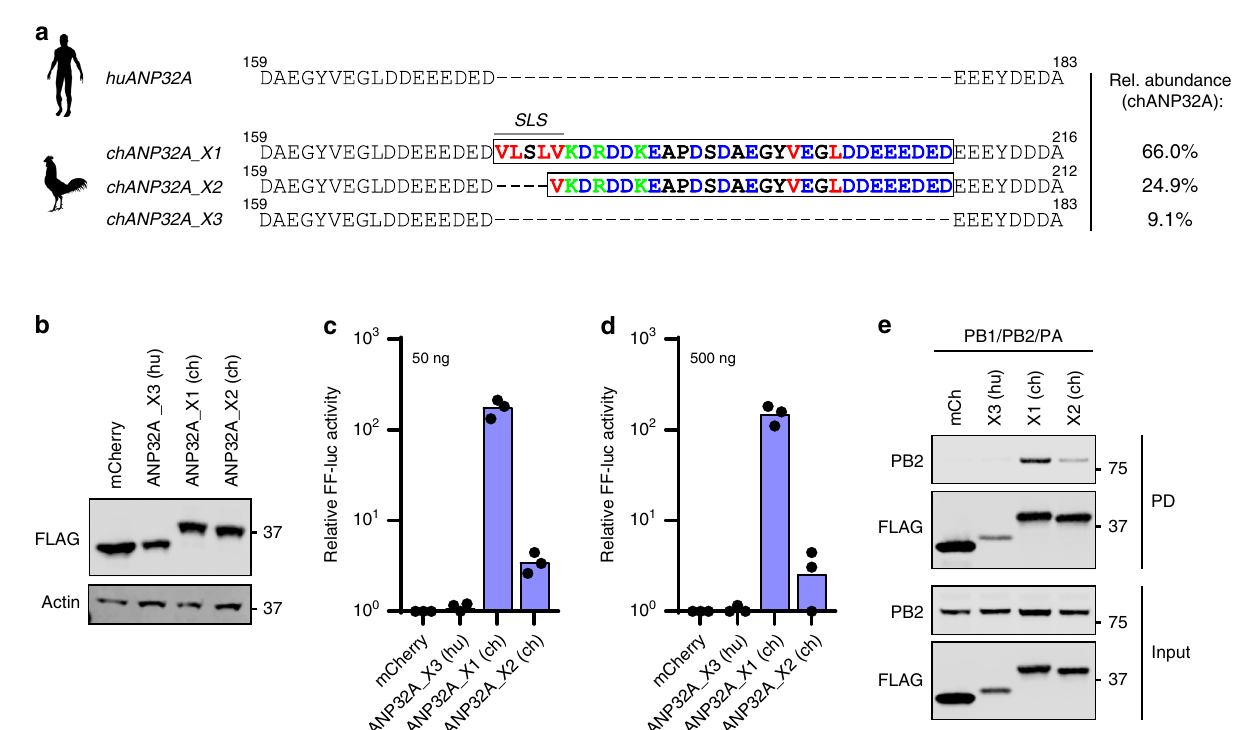
Fig. 1 Avian species express at least three ANP32A variants that differentially impact avian-signature IAV polymerase activity. a Sequence alignment between human ANP32A (huANP32A, Homo sapiens , NP_006296.1) and chicken ANP32A (chANP32A, Gallus gallus _X1, XP_413932.3; Gallus gallus